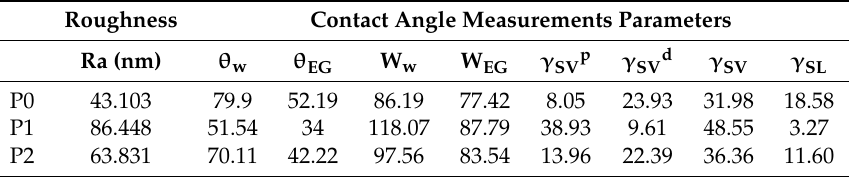
Table 1. Surface roughness and wettability results.